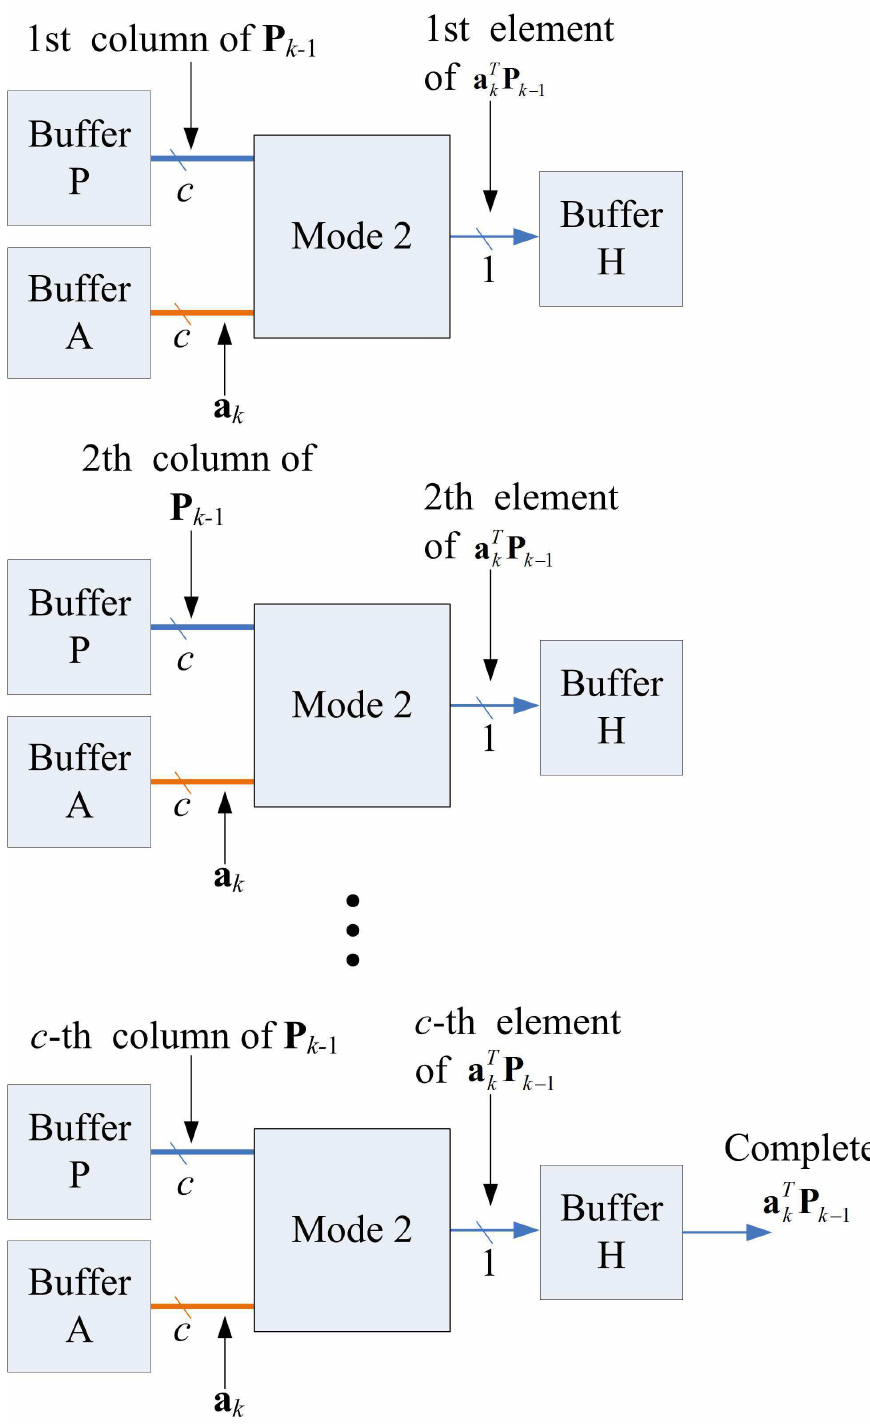
Figure 15. Multiple-step operations of state